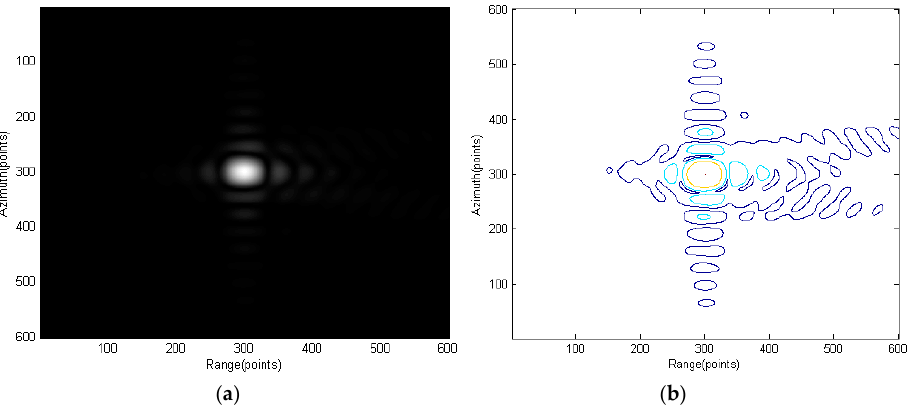
Figure 11. Spectrum comparison after Stolt mapping: ( a ) traditional Stolt mapping and ( b ) proposed Stolt mapping.